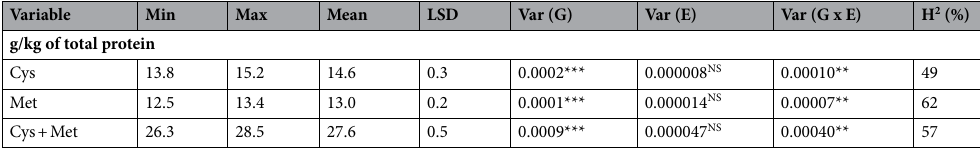
Table 1. Descriptive statistics for cysteine, methionine and the sulfur amino acid content across two sites (two replicates per site). LSD at the 0.05 probability level. Var(G) = genotypic variance, Var(E) = environmental variance, Var(GxE) = Genotype by environment variance and H 2 = Broad sense heritability. NS Not significant at α = 0.05. **, ***Significant at the 0.01 and 0.001 probability levels,